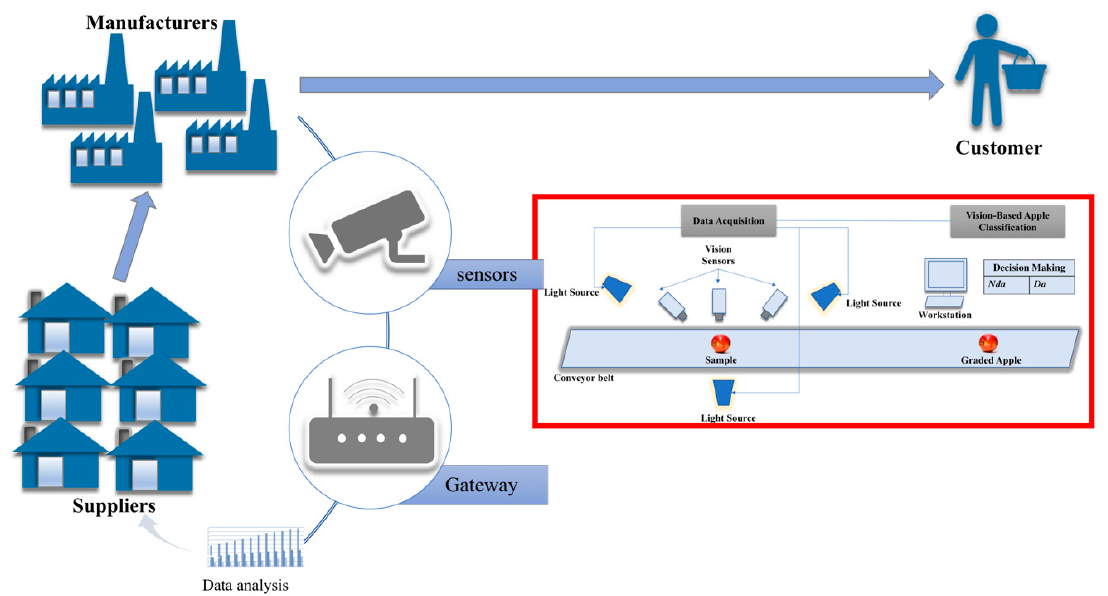
Figure 1. Illustration of the proposed vision-based apple classification for smart manufacturing which employs visual sensors for visual data acquisition (defective apple ( Da ) and non-defective apple ( Nda )).